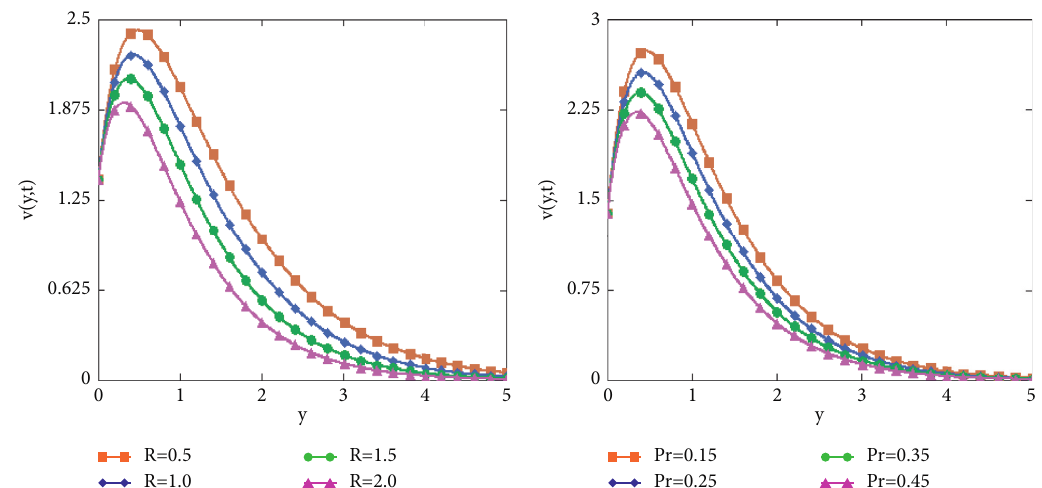
Figure 5: Velocity diagram v ( y, t ) for distinct values of chemical reaction parameter R and Pr at Q � 0 . 4 , Gr � 9 , Gm � 6 , M � . 85 , Sc � 4 . 5 , α � β � c � 0 . 5 , and B � 0 .